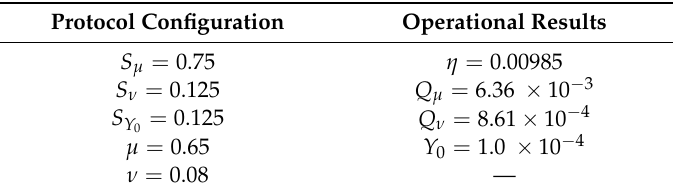
Table 6. Example Decoy State Protocol